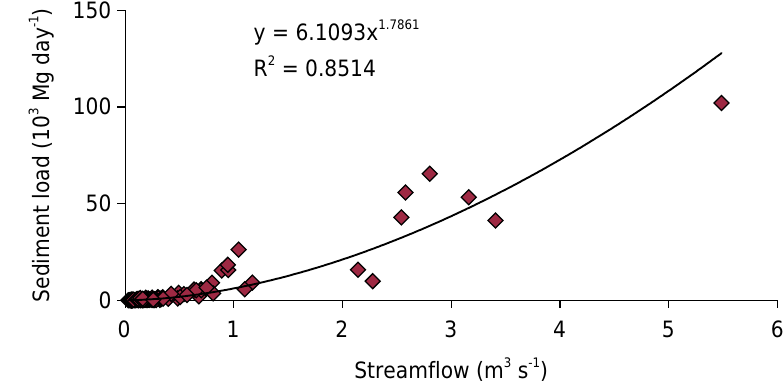
Figure 2. Rating curve for sediment load for the Posses